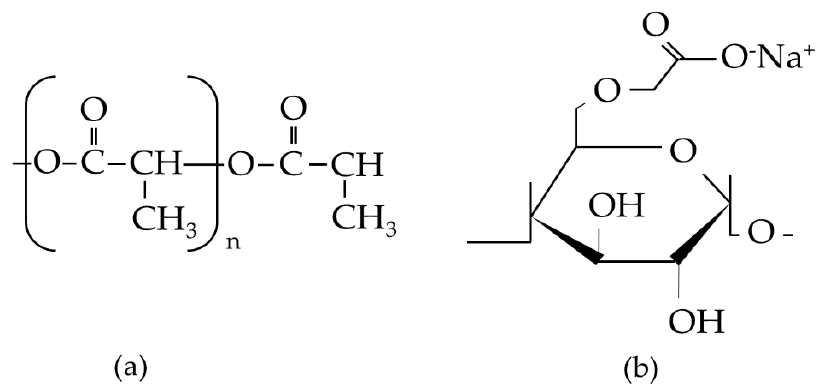
Figure 1. Formula structure of ( a ) poly( L -lactide acid) (PLLA) and ( b ) carboxymethyl starch